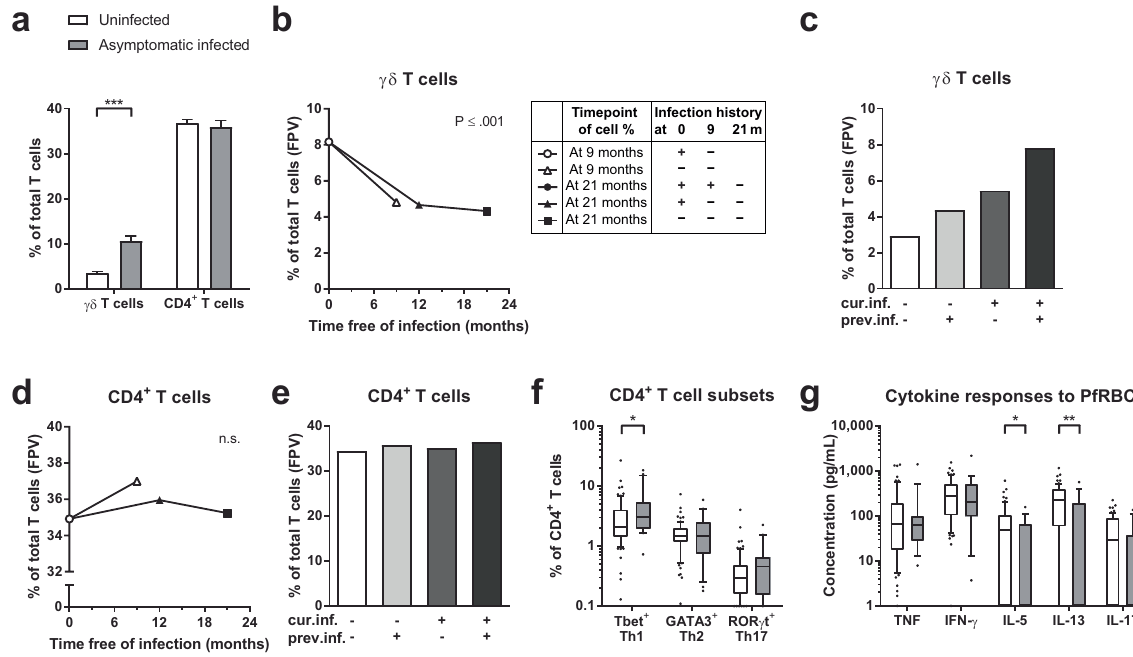
Figure 1. Profiles of γδ T cells and CD4 + T cells. ( a ) The percentage of γδ T cells and CD4 + T cells amongst total T cells compared between uninfected and asymptomatic infected children at baseline. Bar graphs show means and standard errors of the mean (SEM). ( b , d ) The percentage of γδ T cells and CD4 + T cells in children uninfected at either the 9 (open symbols) or 21 months’ (closed symbols) time point plotted against the time period these children were found to be free of infection. Data shown are fixed predicted values (FPVs) of linear mixed modelling. The legend shows the malaria infection status at baseline (0 months), and after 9 and 21 months of follow-up; + indicates infected and - indicates uninfected. The statistical significance of the change in cell percentage over time is indicated by the P value. ( c , e ) The percentage of γδ T cells and CD4 + T cells amongst total T cells compared between currently infected (cur.inf.) and/or previously infected (prev.inf.) children, i . e . recently and longer-time infected and uninfected children within the study period. ( f ) The percentage of Th1, Th2, and Th17 subsets amongst CD4 + T cells compared between uninfected and asymptomatic infected children at baseline. Box plots show medians and 10–90% whiskers. ( g ) TNF, IFN- γ , IL-5, IL-13, and IL-17 cytokine responses of PBMCs to PfRBC stimulation, after background subtraction of responses to uninfected RBC, compared between uninfected and asymptomatic infected children at baseline. * indicates analysis with independent-samples T test (bar graphs) or Mann-Whitney U test (box plots) of baseline data. Analysis with linear mixed models of all time points together is shown in Supplementary Figure S1. * P ≤ 0.05. ** P ≤ 0.01. *** P ≤